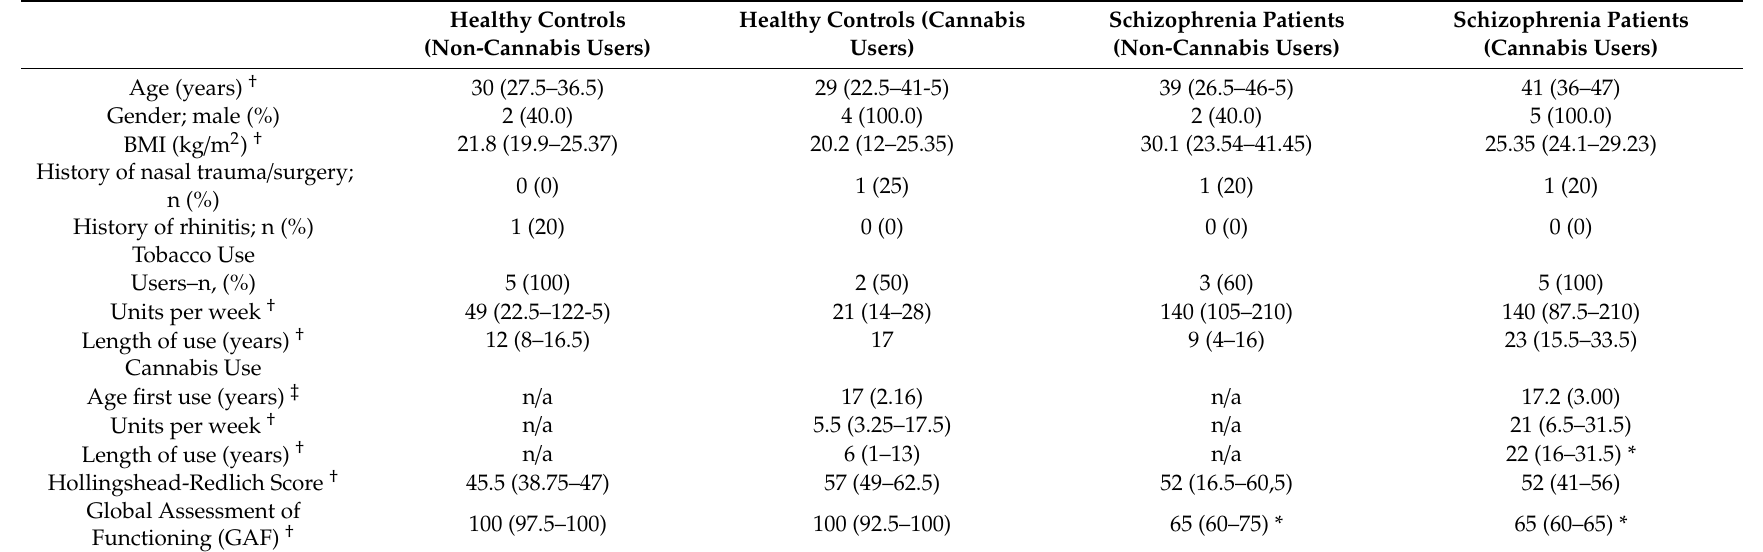
Table 1. Demographic, socioeconomic, and functional characteristics of the